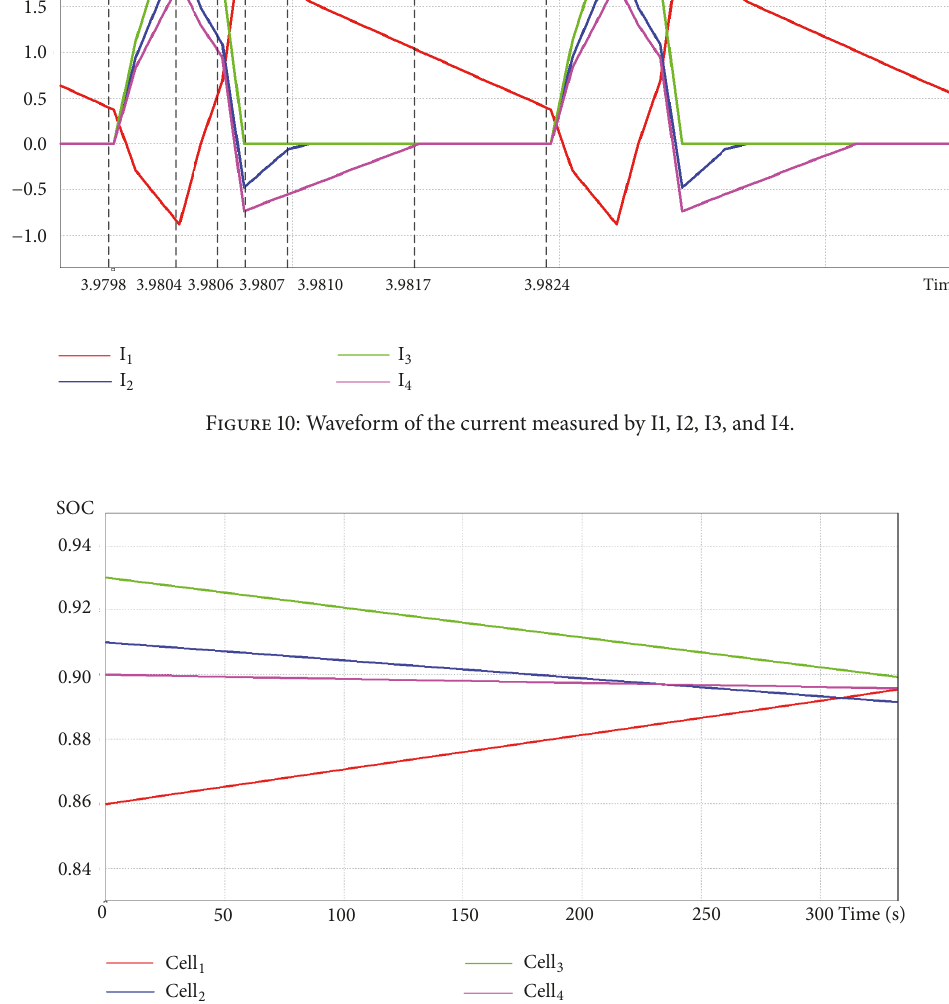
Figure 11: SOC waveform for the ideal gating